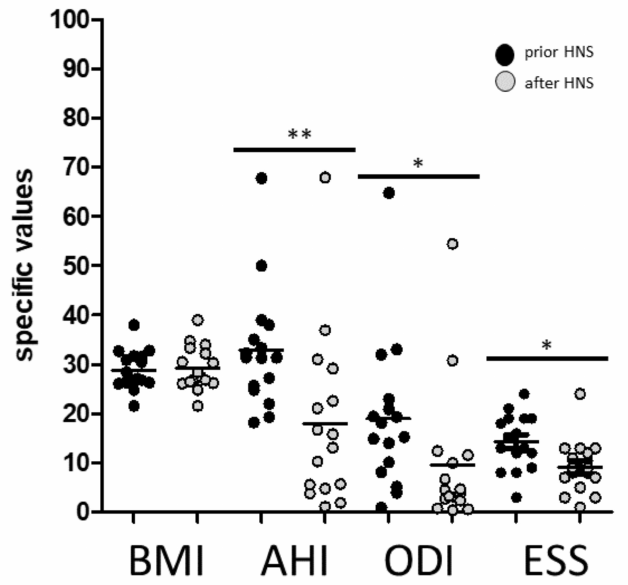
Figure 1. Values of BMI (body mass index), AHI (apnea–hypopnea index), ODI (oxygen desaturation index), and Epworth Sleepiness Scale (ESS) before and after HNS therapy. *: p < 0.05; **: p < 0.01. Post hoc power calculation was performed for the significant differences and revealed values of 100% for both AHI and